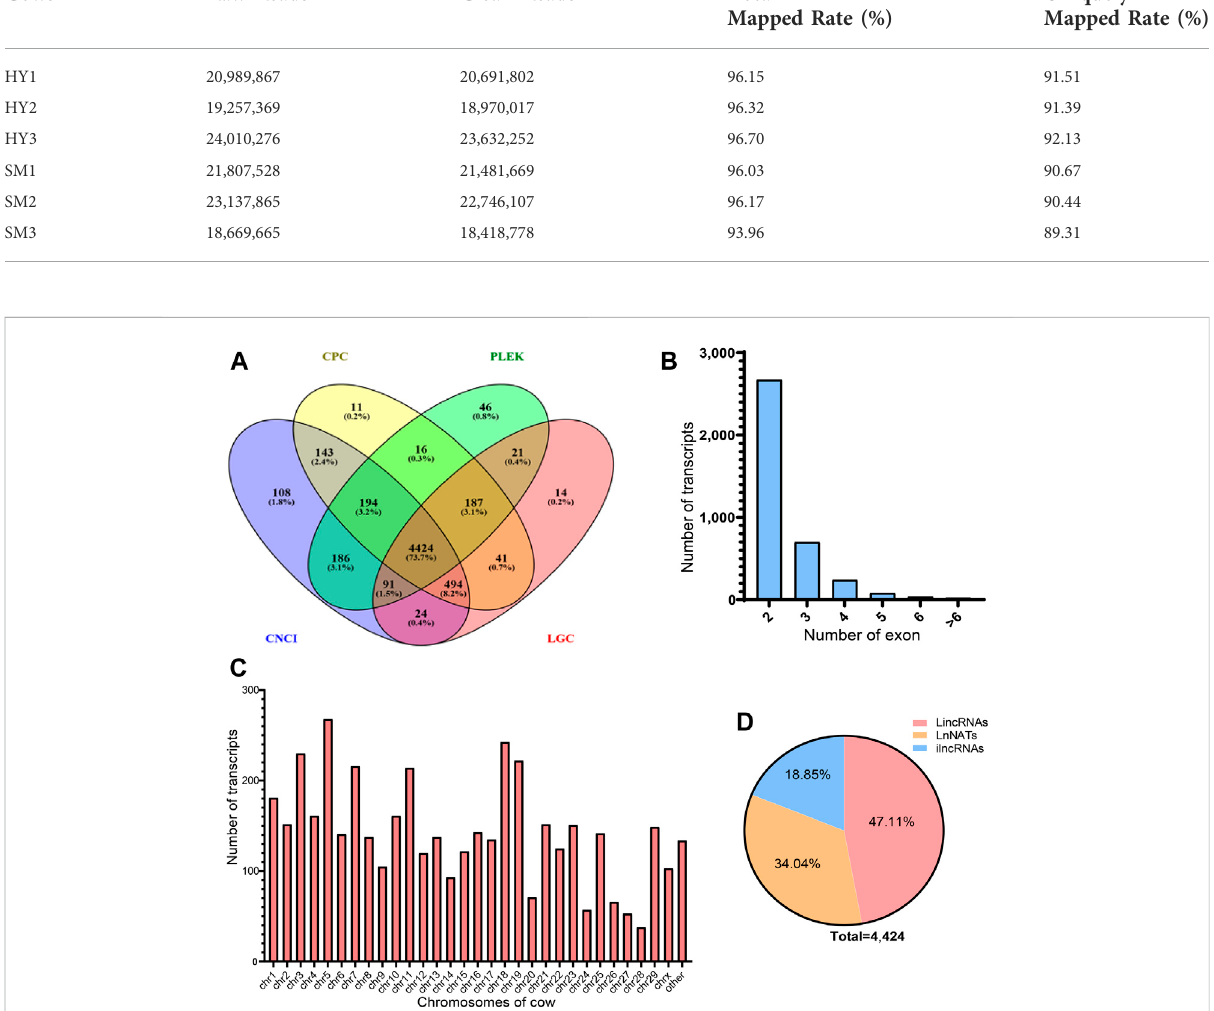
FIGURE 1 Identi fi cation and characterization of lncRNAs in cows with subclinical mastitis and healthy cows. (A) The Venn diagram of novel lncRNAs. The intersection part showed the novel lncRNAs predicted by the coding potential prediction software CPC, PLEK, CNCI, and LGC together. (B) Exon numberofidenti fi edlncRNAstranscripts. (C) Distributionofidenti fi edlncRNAstranscriptsonallchromosomes. (D) Among4,421lncRNAtranscripts, the proportion of intronic lncRNA (ilncRNA), Intervening lncRNAs (lincRNA), and antisense lncRNA